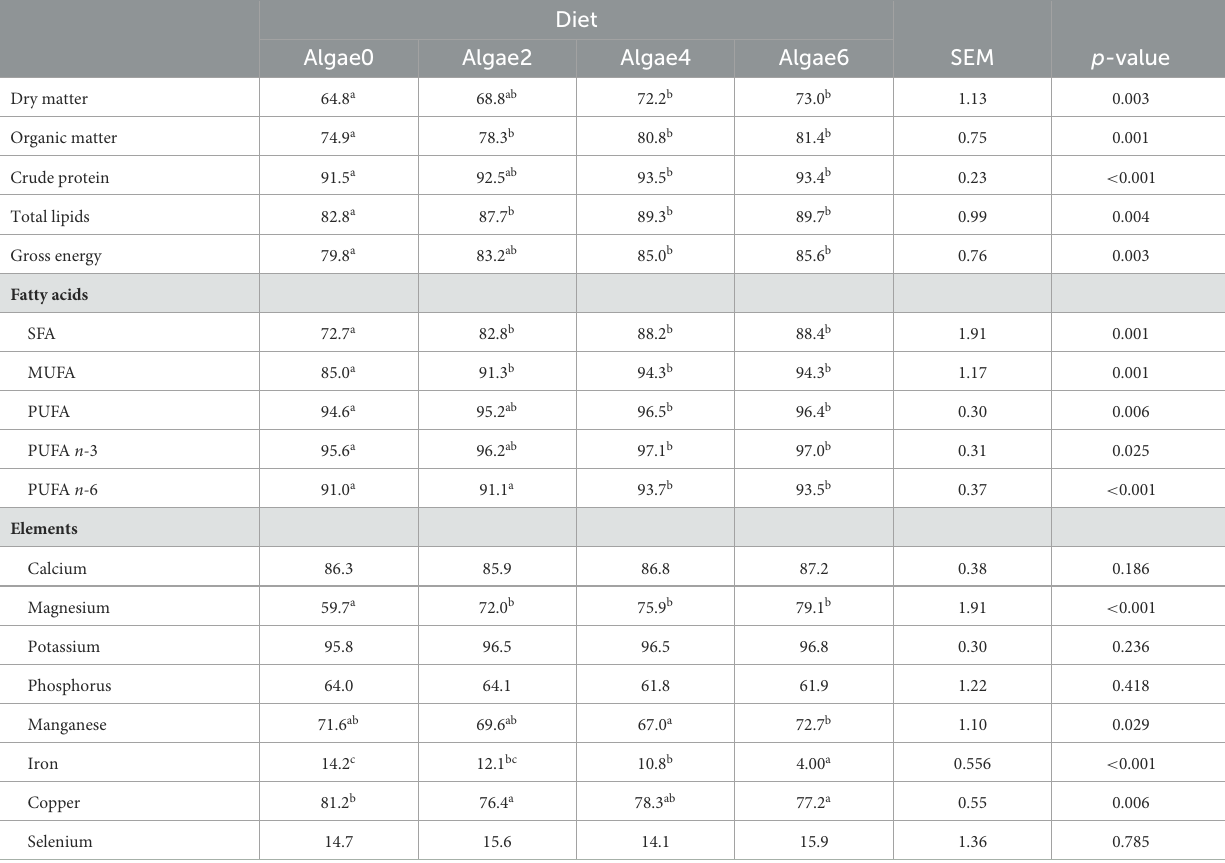
TABLE 2 Apparent digestibility coefficients (%) of nutrients, energy, and minerals of the experimental diets fed to European seabass juveniles. Diet Algae0 Algae2 Algae4 Algae6 SEM p-